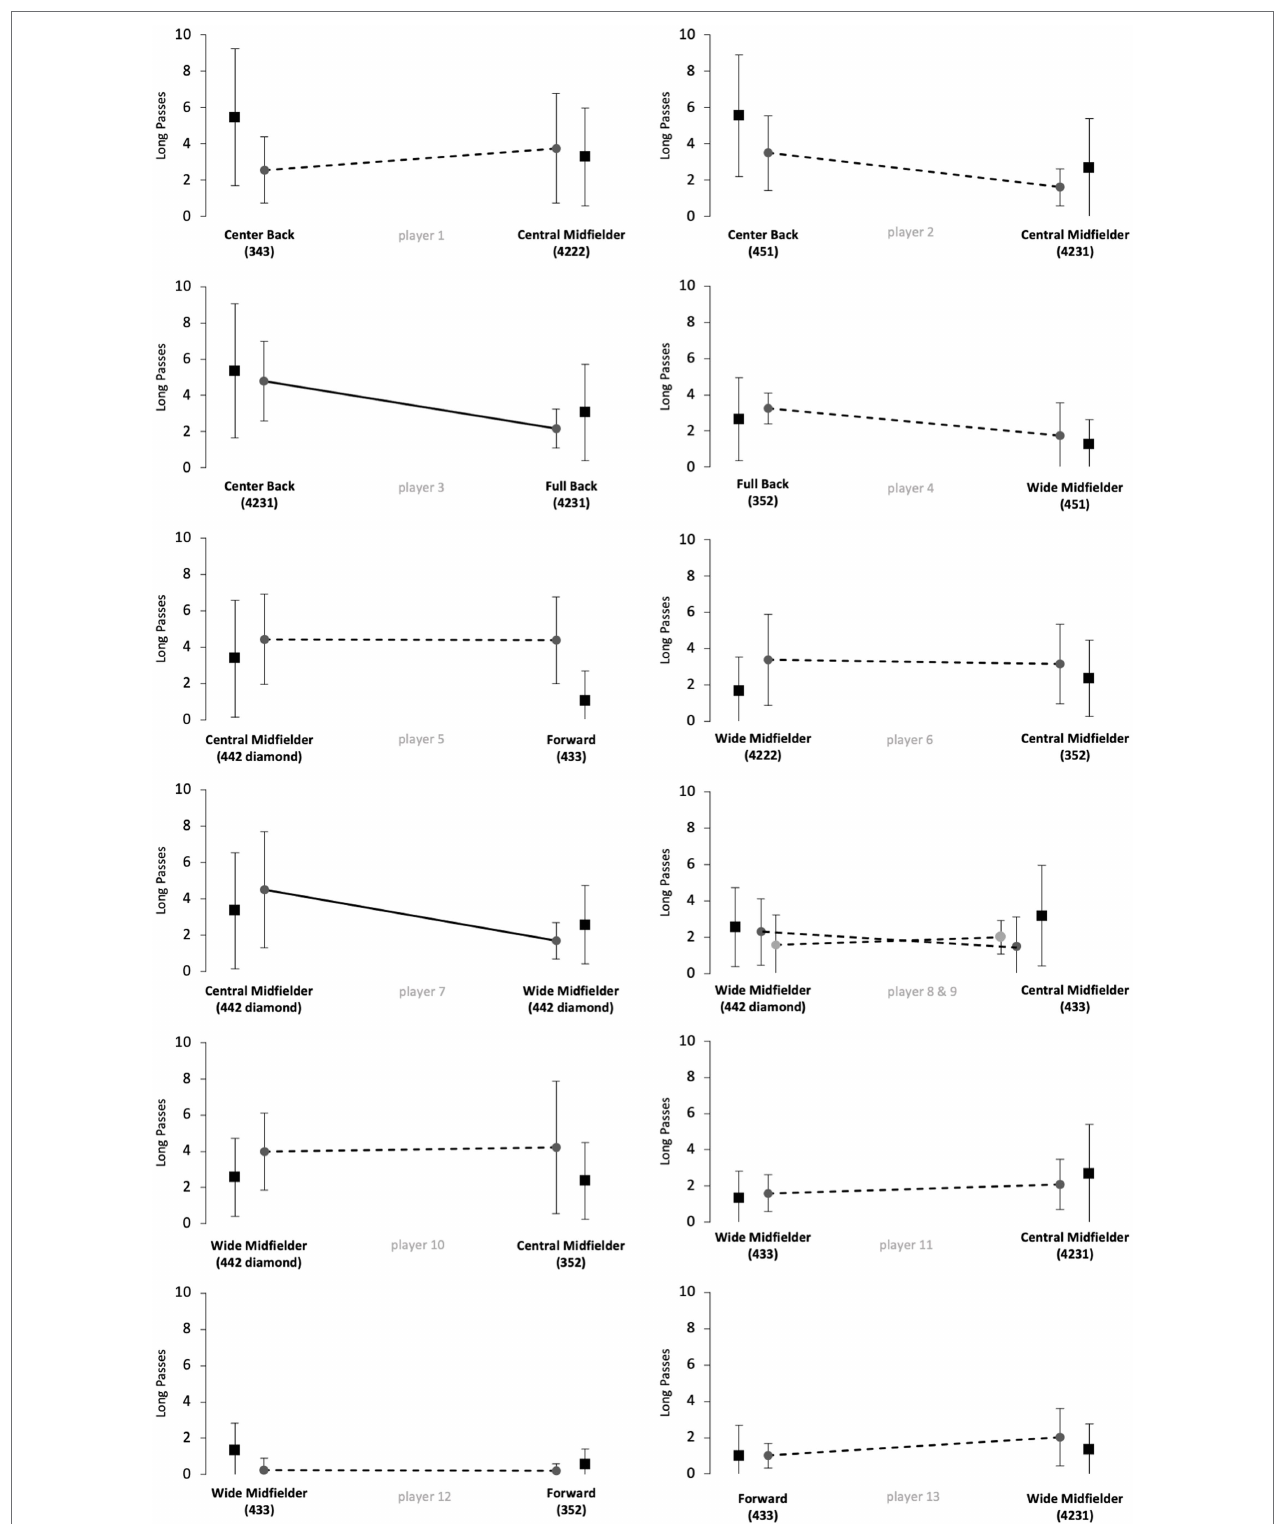
FIGURE 3 | Number of long passes of players from the study sample (grey circles) in relation to normative positional data (black squares). Data are presented as means ± SD for the respective games played on the respective positional role. Solid lines indicate significant differences in performance between the two positions for the respective